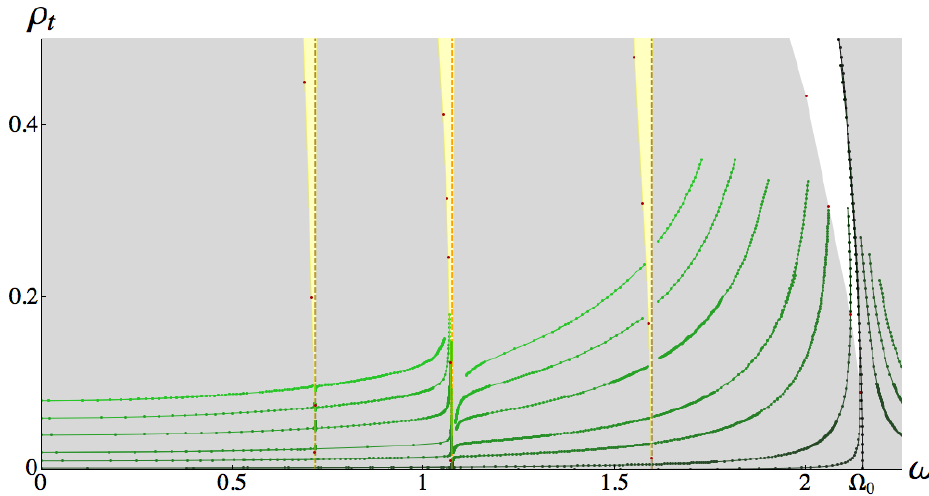
Figure 1 . Points in the shaded region correspond to linearly stable TPSs. Solutions in the white region are linearly unstable; once perturbed, they evolve either to multiperiodic (even chaotic) geometries or black holes. Red points signal the data constructed through quasistatic quenches needed to determine the thresholds of shaded areas. Solid lines are level curves of constant (cid:26) . Emerging from (cid:10) 0 , we see the (cid:12)rst line of nonlinear gravitational normal modes (solid black), which corresponds to TPSs with (cid:26) = 0. Finally, dashed lines indicate zones where the frequency of the source, ! , resonates with some of the frequencies of the normal modes, (cid:10) n , the orange one ! = (cid:10) 0 = 2 and the brown ones from left to right ! = (cid:10) 0 = 3 ; (cid:10) 1 = 3. Around these resonances (yellow regions), no TPSs were found. More resonances are expected at ! = (cid:10) n =k , for n; k 2 N